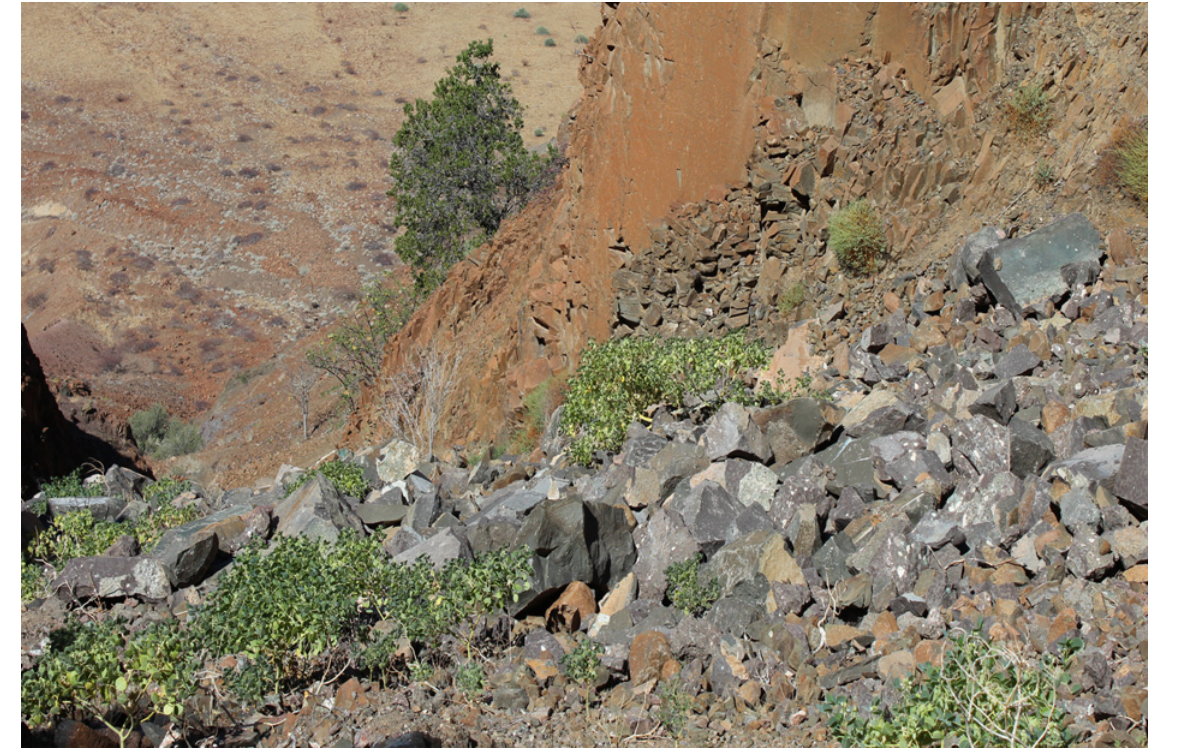
Fig 1. Natural habitat of Oberholzeria etendekaensis . Plants of O . etendekaensis in their natural habitat (low-growing shrublets in foreground), Etendeka Mountains, Namibia. The plants grow in stony soil and scree derived from basalt of the Etendeka Group, Karoo Supergroup. This section of the Great Escarpment lies to the east of the Namib Desert, about 50 km from the Atlantic Ocean coastline. The climate is very arid, with an average annual rainfall of about 100 mm. Photo: W. Swanepoel.